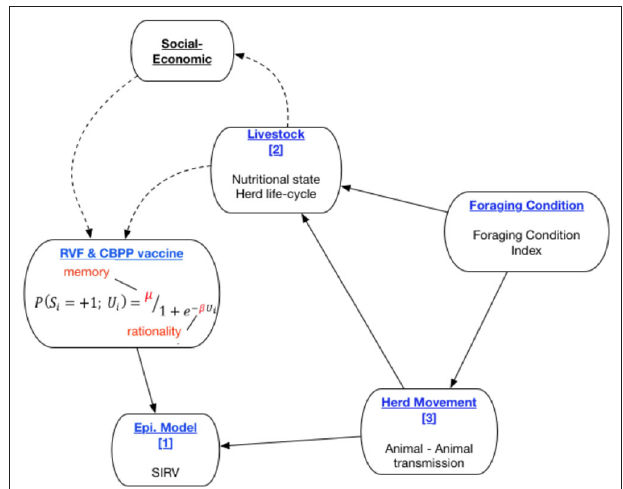
FIGURE 1 | Overview of preliminary PastoralScape